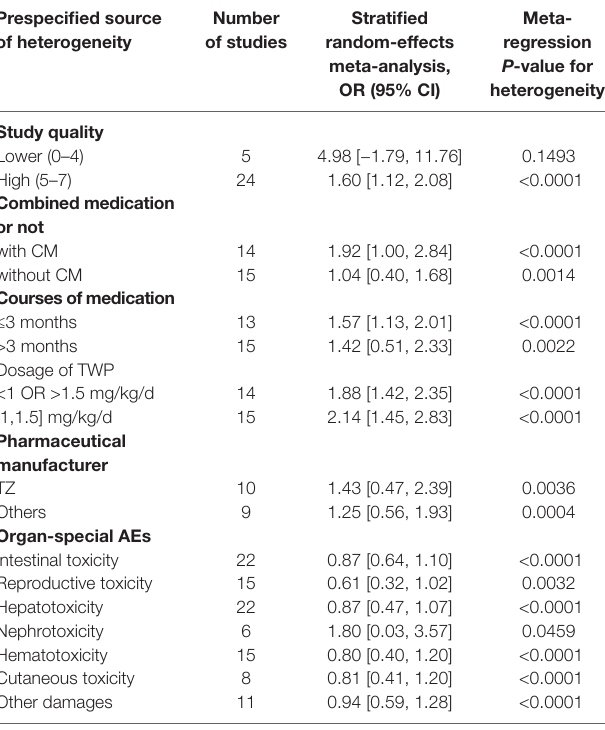
TABLE 2 | Potential prespecified sources of heterogeneity among the studies reporting AEs associated with TWP